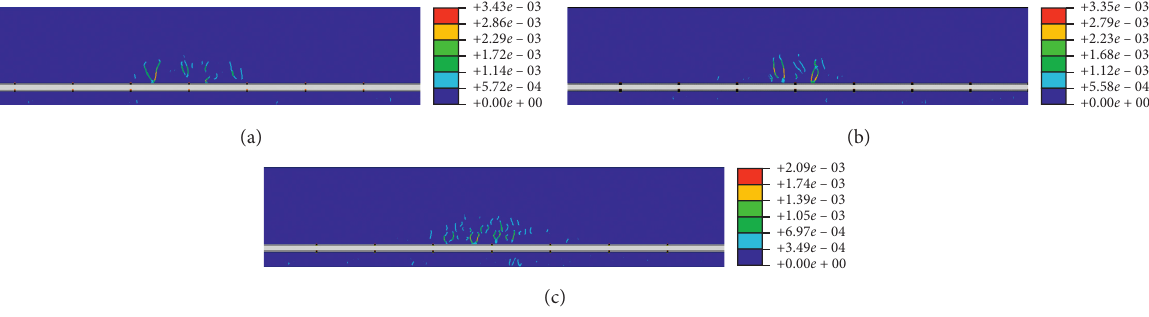
Figure 11: RC beam with different aggregate contents: (a) 25%, (b) 30%, and (c)